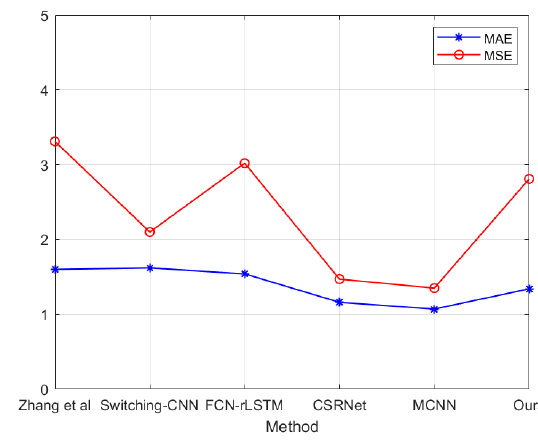
ff erent methods for the UCSD Figure 11. The MAE and MSE of different methods for the UCSD dataset. Figure 11. The MAE and MSE of di